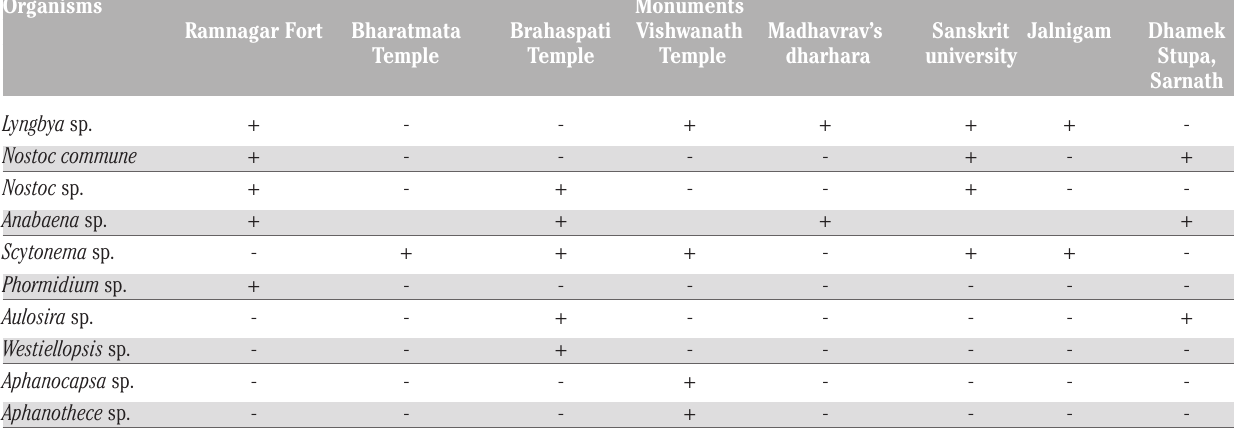
Figure 1. Cyanobacterial crust collection sites of Varanasi, India.